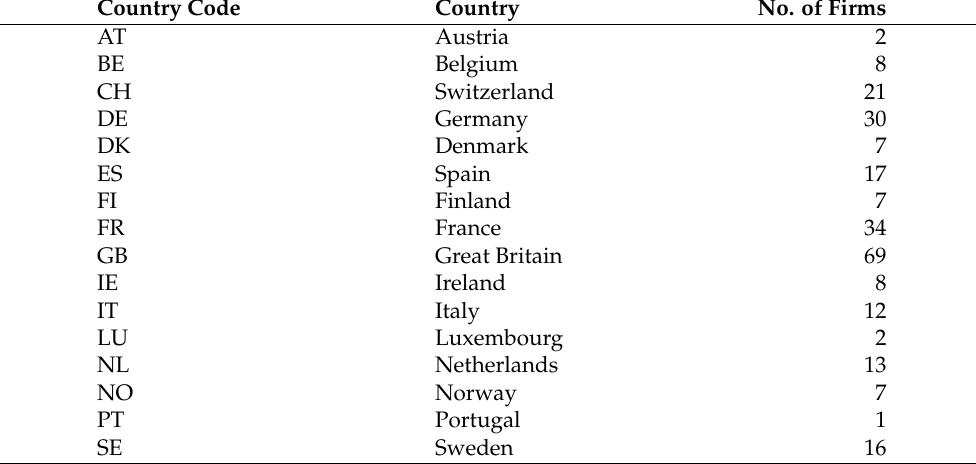
Table A10. Countries .